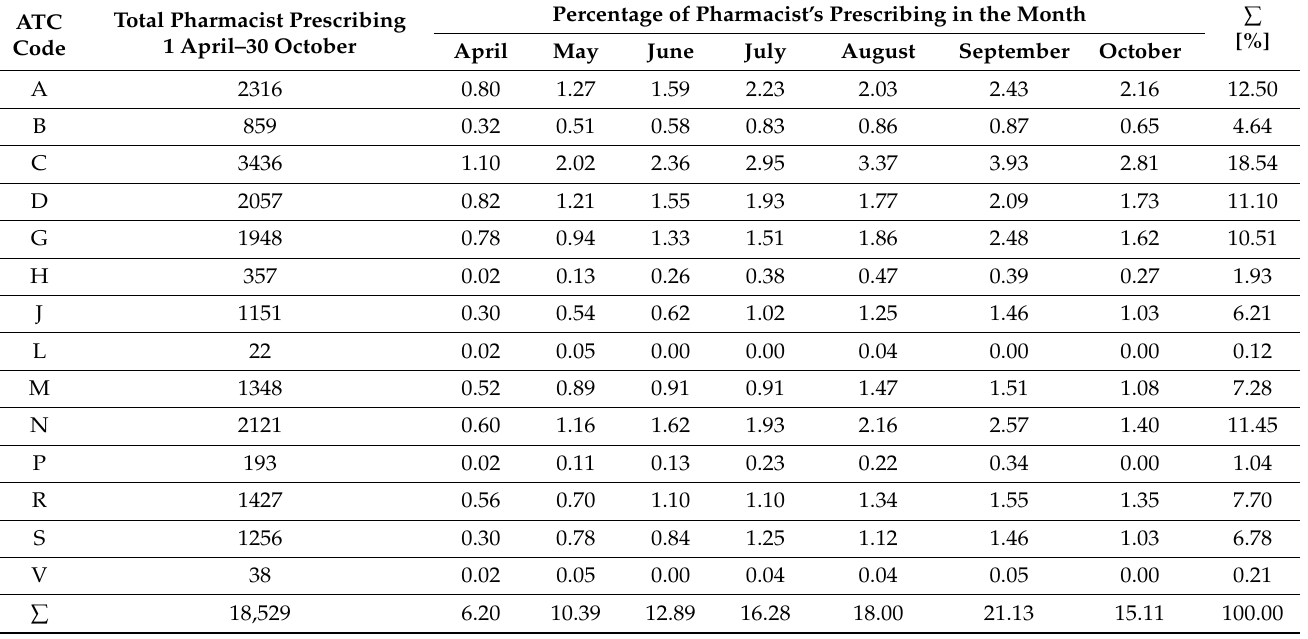
Table 4. Prescribed drugs by pharmacists according to the ATC Classification System in the analyzed region from 1st